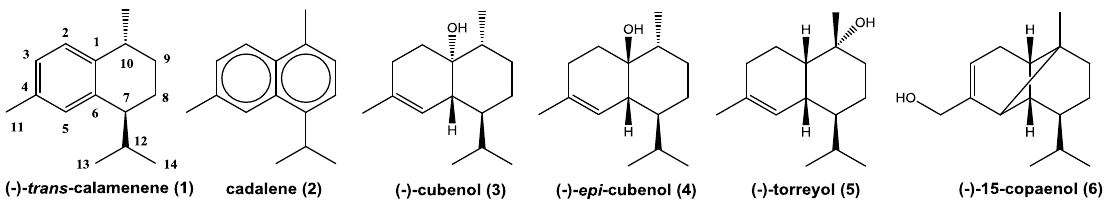
Figure 1. Sesquiterpenes isolated from heartwood of Pilgerodendron uviferum . Table 1. Relative abundances (%) of compounds present in the essential oil (EO), petroleum ether extract (PEE), and dichloromethane extract (DCME) of P. uviferum heartwood. RT indicates retention time (min), RI C indicates the calculated retention index, and RI L indicates retention index from literature [26], MS indicates the mass spectrometry, and * indicates the relative abundances of the EO compounds (extracted from [18]).